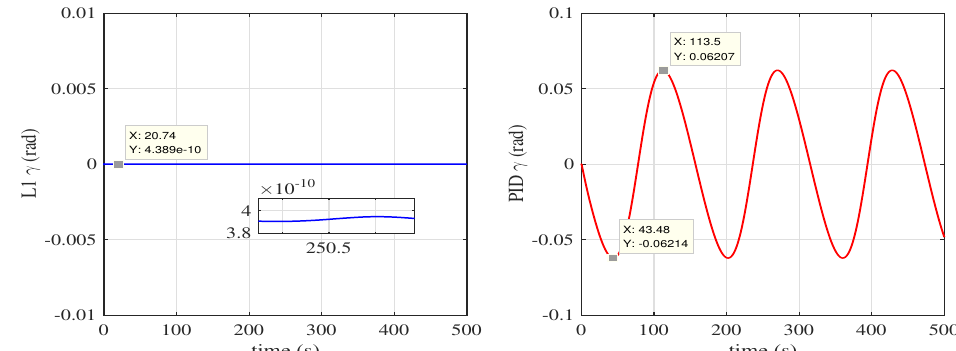
Figure 7. Track angle proposed by PID and L 1 controller in horizontal flight and fault